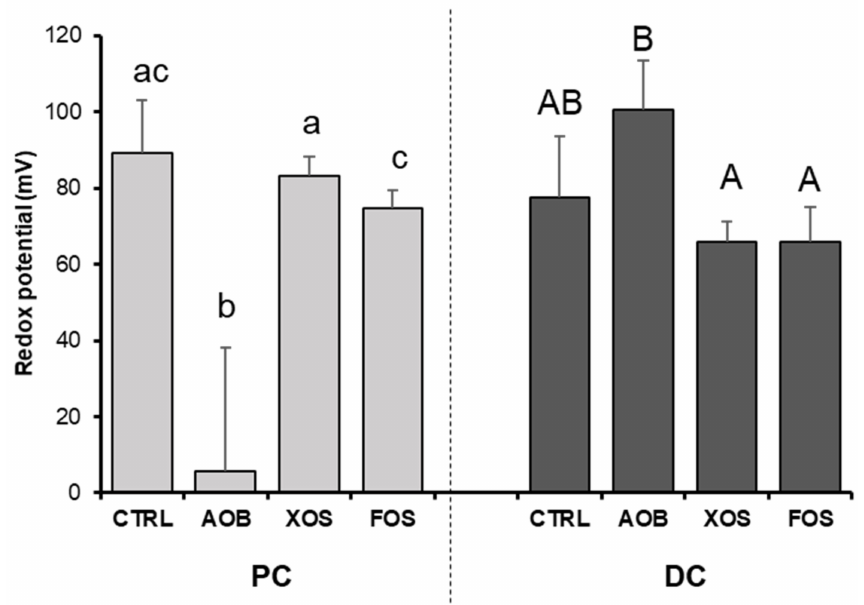
Figure 8. Changes in redox potential for donor 2 and 4, upon treatment with AOB, XOS and FOS versus a blank control for PC and DC. Data are averages of two technical replicates for both donor 2 and 4 with standard deviation STDEV ( n = 4). CTRL = control; AOB = antioxidant blend; XOS = xylooligosaccharides; FOS = fructooligosaccharides; PC = proximal colon; DC = distal colon. Significant differences ( p < 0.05) are indicated with small letters (a, b, c) for the proximal colon and capital letters (A, B) for the distal colon. Bars with different letters are significantly